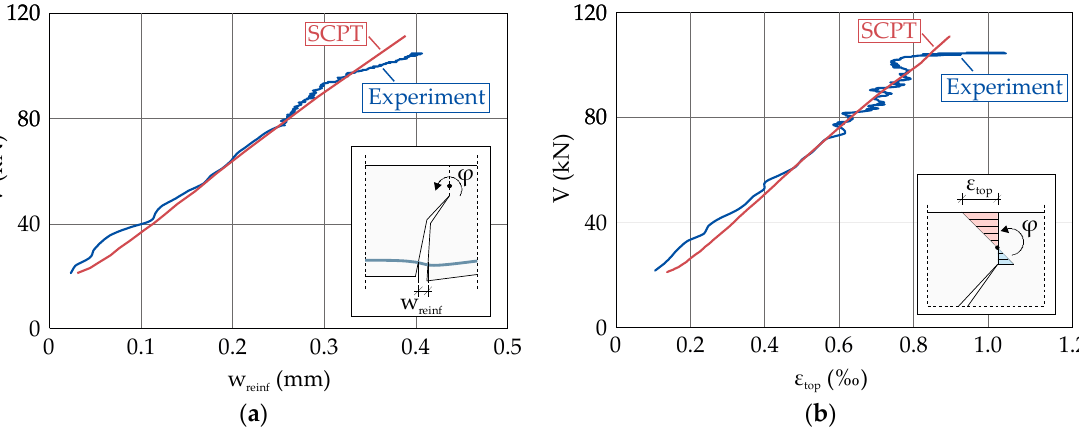
Figure 7. Experimental and calculated (SCPT) results for: ( a ) the crack opening w reinf at the height of the reinforcement layer and ( b ) the maximum concrete compressive strain ε top in the top fiber of the uncracked zone.